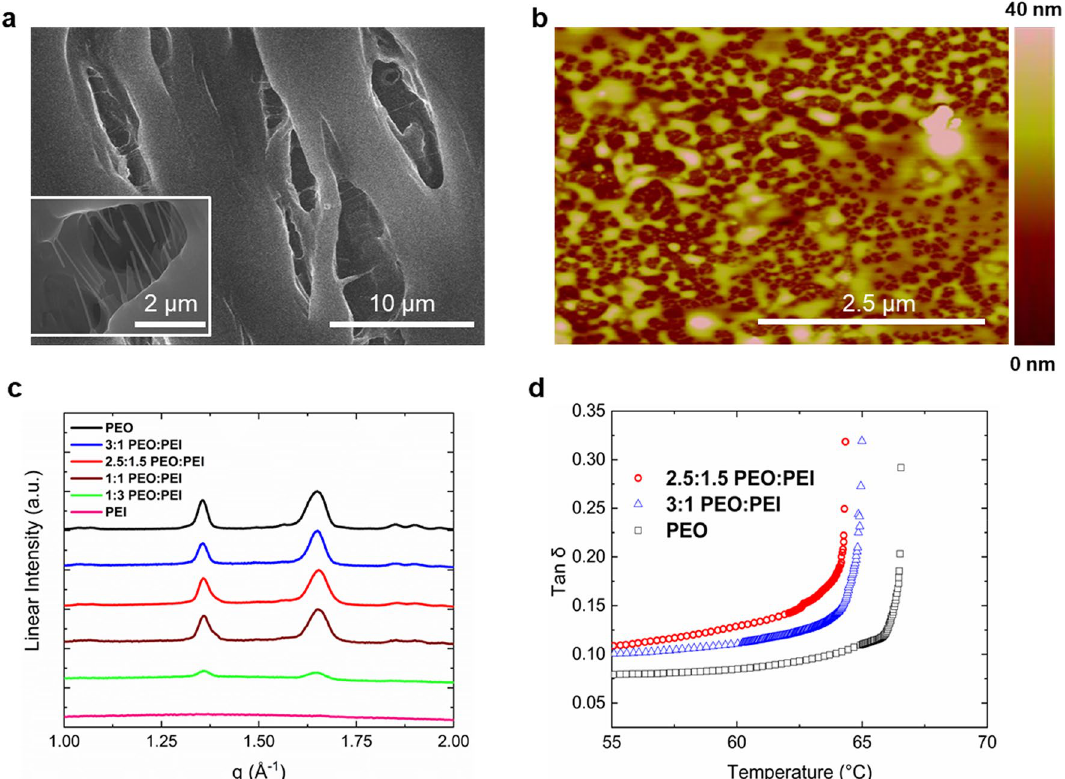
Figure 4. ( a ) SEM images of a 3:1 PEO:PEI blend film. Both images shown are of the same film but in different sections and locations. ( b ) AFM images of a 3:1 PEO:PEI blend films. ( c ) XRD patterns of PEO, 3:1 PEO:PEI blend, 2.5:1.5 PEO:PEI blend, 1:1 PEO:PEI blend, 1:3 PEO:PEI blend, and PEI only films. ( d ) DMA of a 2.5:1.5 PEO:PEI blend, 3:1 PEO:PEI blend, and PEO-only